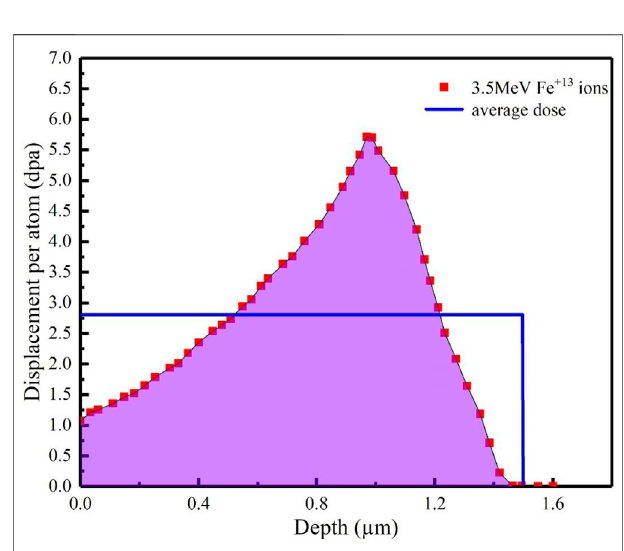
FIGURE 8 | Peak irradiation damage dose of ~5.7 dpa and the average dose calculated by the SRIM code.